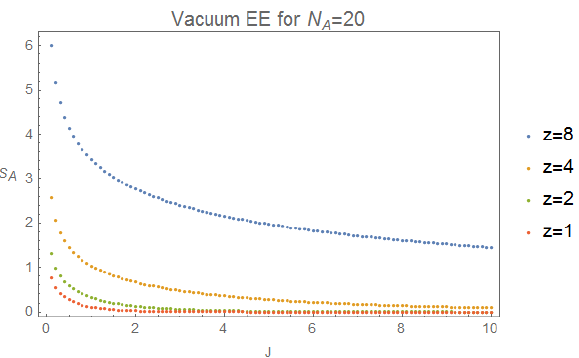
= 20 and different fixed values of z . Note that Figure 2: Plot of vacuum EE as a function of J for N A in the UV, the lattice spacing ε is very small, which implies J (cid:28) 1, while in the IR, ε is very large, which implies J (cid:29) 1. In this J (cid:29) 1 regime, the correlation length, inversely proportional to J , becomes smaller than the lattice spacing, and we expect the EE to fall off. Thus, we see that regardless of z , as we flow from UV to IR, the vacuum EE S decreases. A